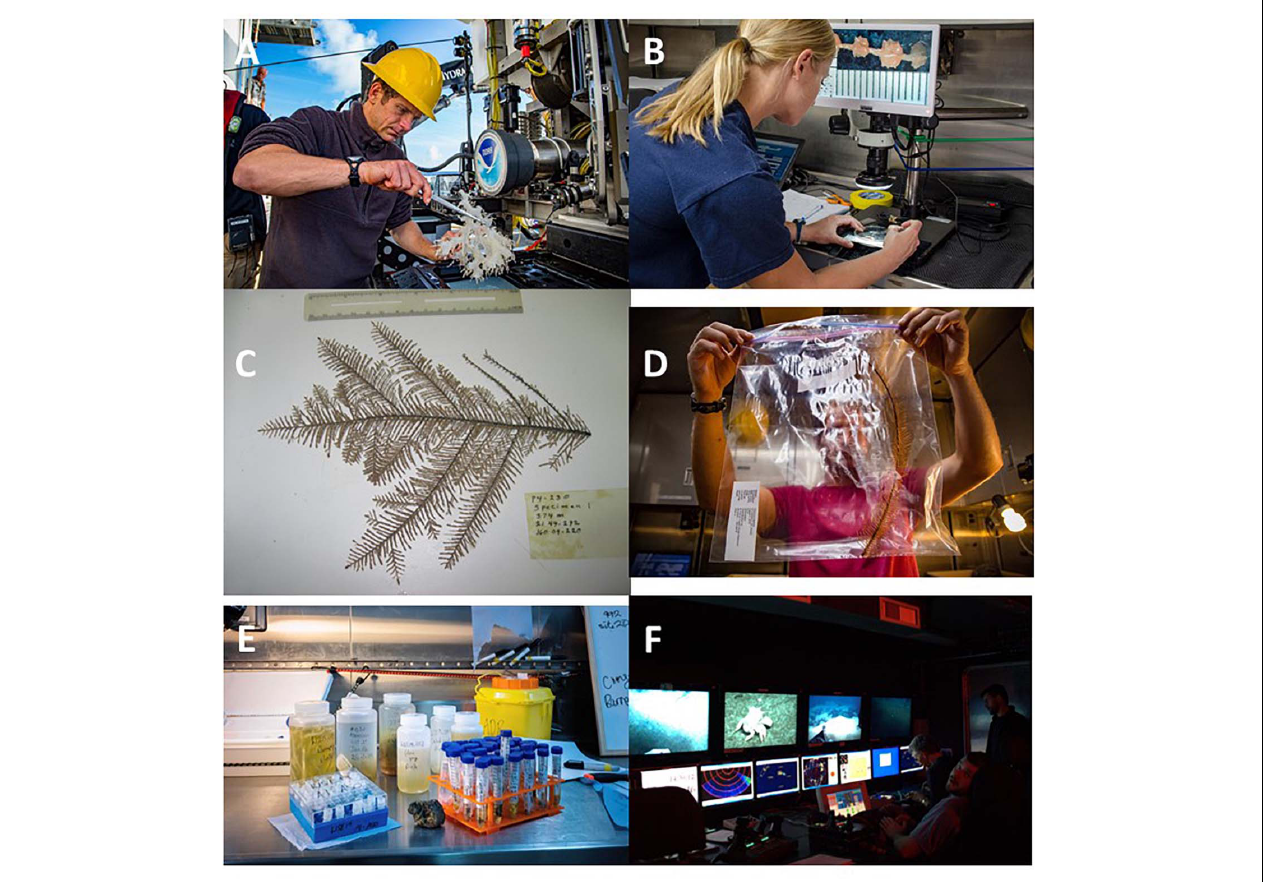
FIGURE 3 | Handling of samples during marine scientific research. (A) Sponge specimen being removed from biobox on ROV science skid (D. Wagner). (B) Specimen of octocoral being photographed in the laboratory on board a ship (D. Wagner). (C) Photograph of black coral specimen showing label with sample details (D. Wagner). (D) Specimen of black coral in plastic bag for preservation with label inserted in bag with sample details (D. Wagner). (E) Samples and sub-samples in containers. Most containers will have sample labels both on the outside of the container and a label inside (A. D. Rogers). (F) ROV control van showing video screens both for navigation and for sampling operations. Sampling operations are recorded so details of the environment where a sample is taken can be retrieved post cruise (A. D.